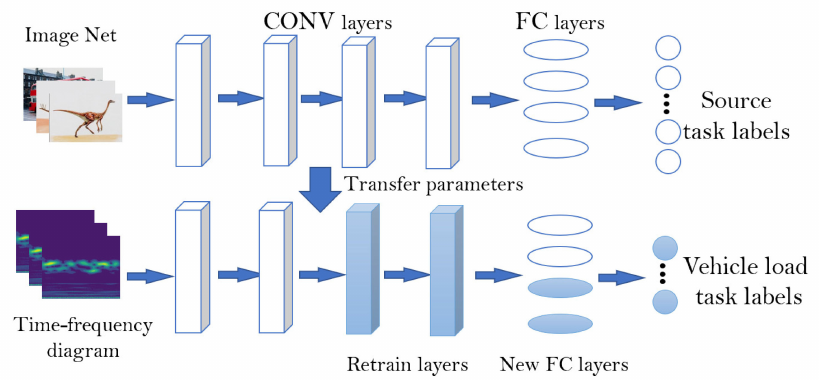
Figure 3. Illustration of transfer learning strategy